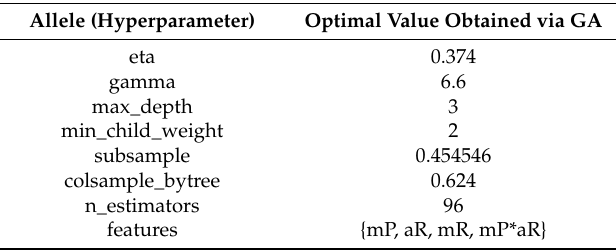
Table 10. Best-evolved values of hyperparameters of XGBoost.